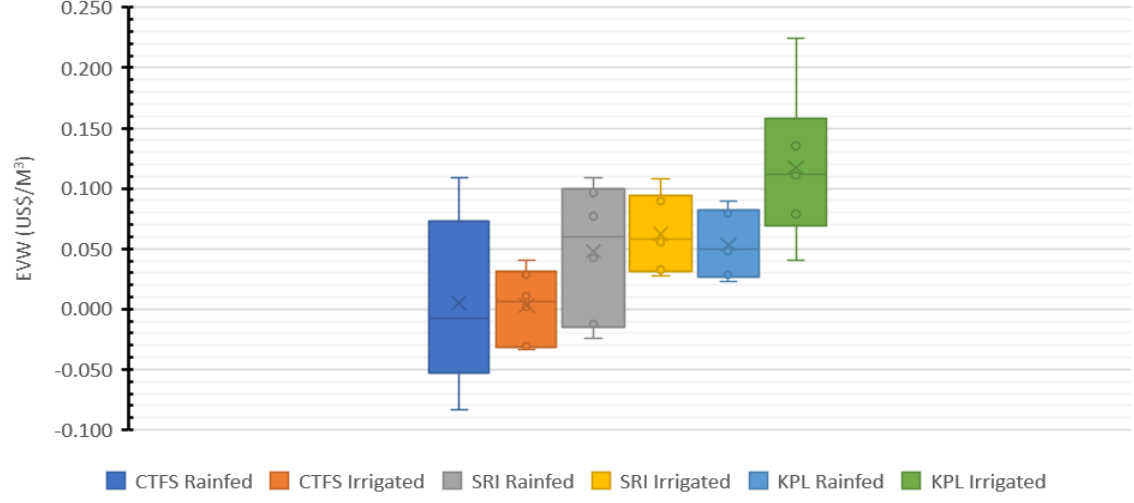
Figure 7. Comparison of the economic value of water for paddy in all the six farming systems.